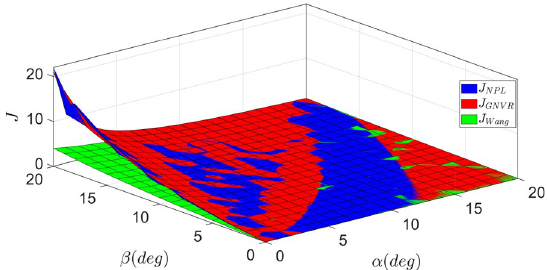
Fig. 23 Cost Function Values of NPL, GNVR and Wang Shapes